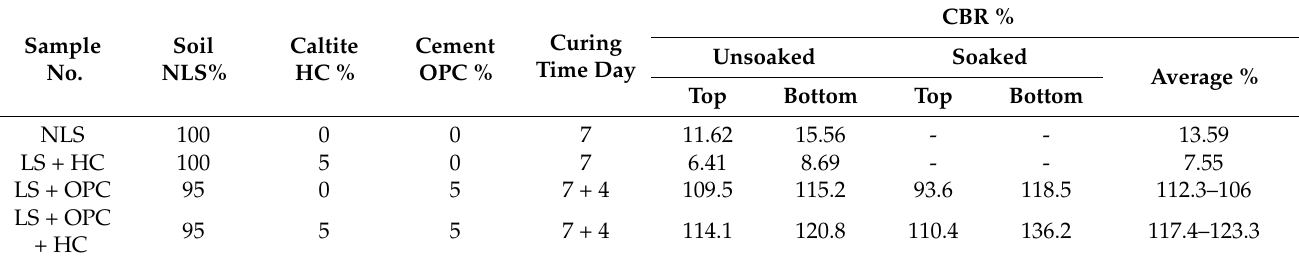
Table 3. Summary of the laboratory CBR